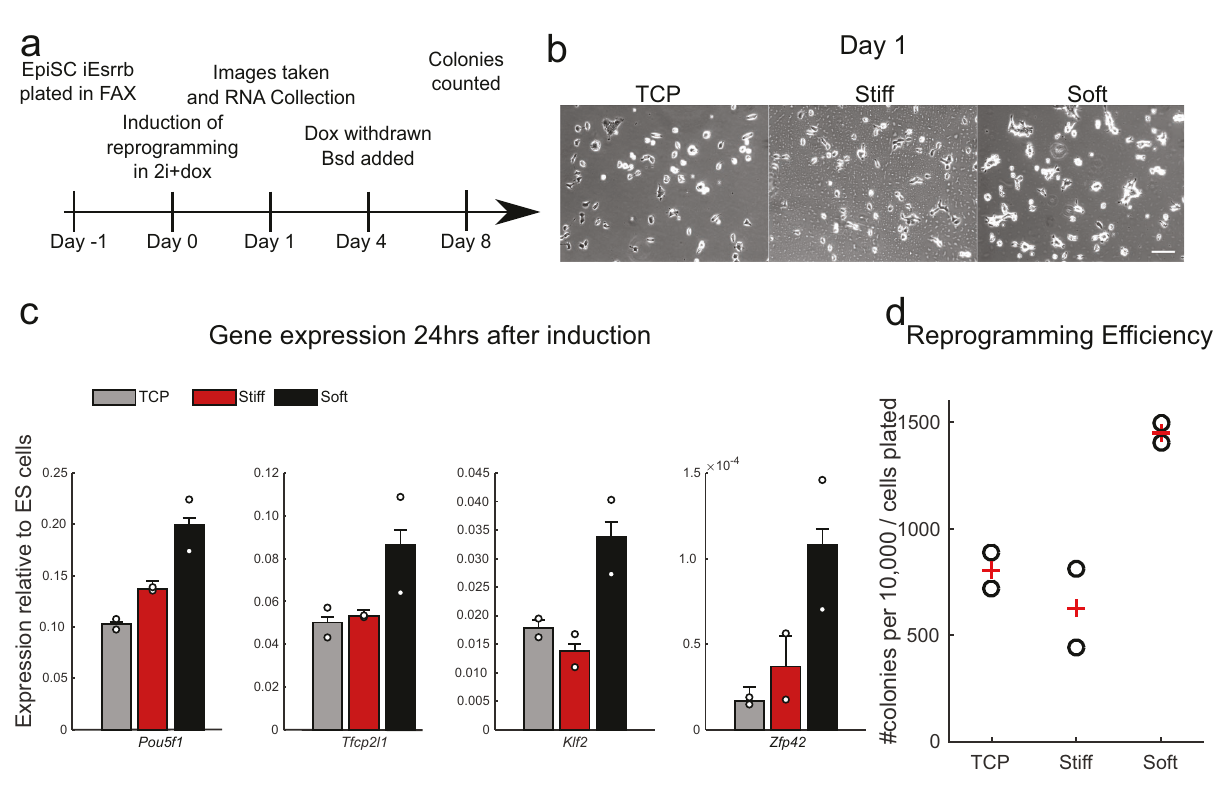
Fig. 5 mEpiSC reprogramming is boosted on soft substrates. a Schematic of reprogramming procedure. EpiSCs were plated in their maintenance Fgf2 + ActivinA + XAV (FAX) medium. iEsrrb -driven reprogramming was induced by switching to 2i + doxycycline (dox) the next day. After 4 days of reprogramming, Dox was withdrawn and blasticidin (bsd) was added to select for naïve colonies with an active Rex1 promoter. Blasticidin-resistant iPSC colonies were counted on day 8. b Phase contrast images 24 h after induction of iEsrrb EpiSC reprogramming in 2i + dox on TCP, stiff and soft substrates. Scale bar, 100 µ m. c Gene expression pro fi le 24 h after induction of iEsrrb EpiSC reprogramming in 2i + dox. Expression is presented relative to Gapdh then normalised to 2i + LIF mESC levels. Circles represent individual data points, bars show average ( n = 2). d Number of iPSC colonies counted on day 8 on TCP, stiff and soft substrates, as a measure for reprogramming ef fi ciency, circles show individual data points, ‘ + ’ show average ( n = 2 samples). See also Supplementary Fig. 6. In all panels, error bars show standard deviation. Source data are provided as a Source Data fi